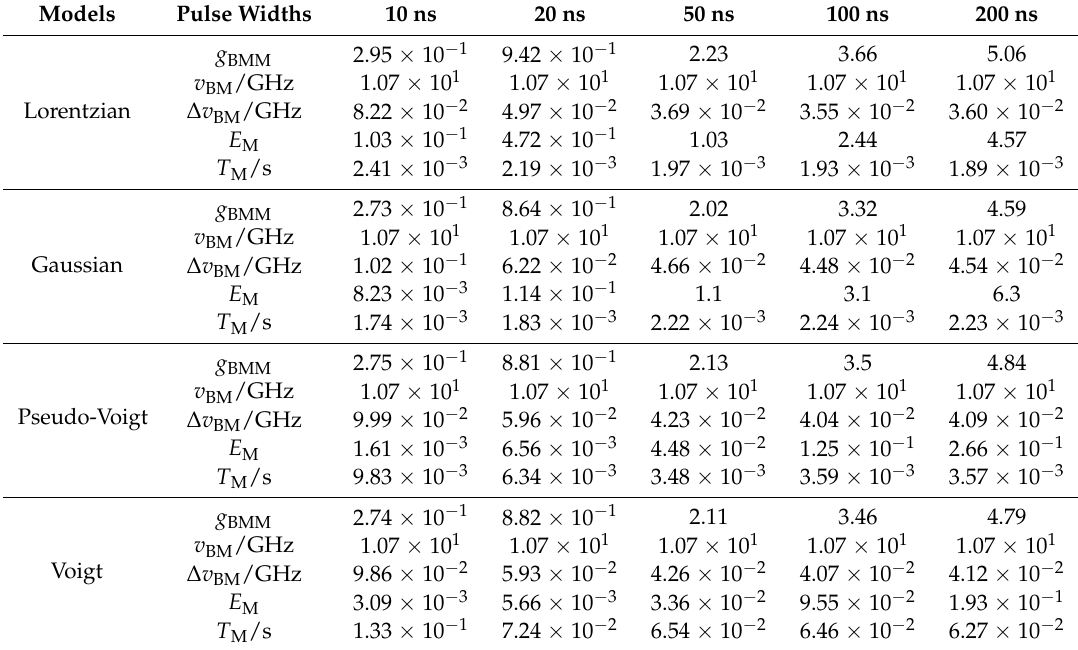
Table 7. Mean value of the key parameters, E and T by different models for spectra with different pulse widths, measured signals with average number of 2 18 .